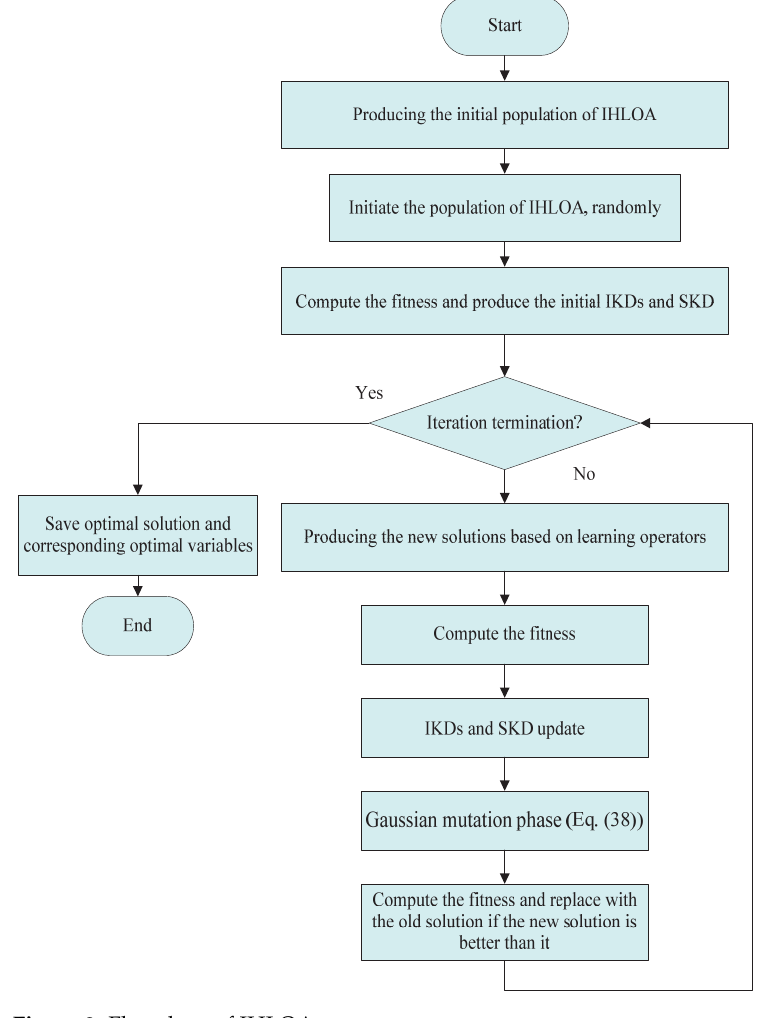
Figure 2. Flowchart of IHLOA.